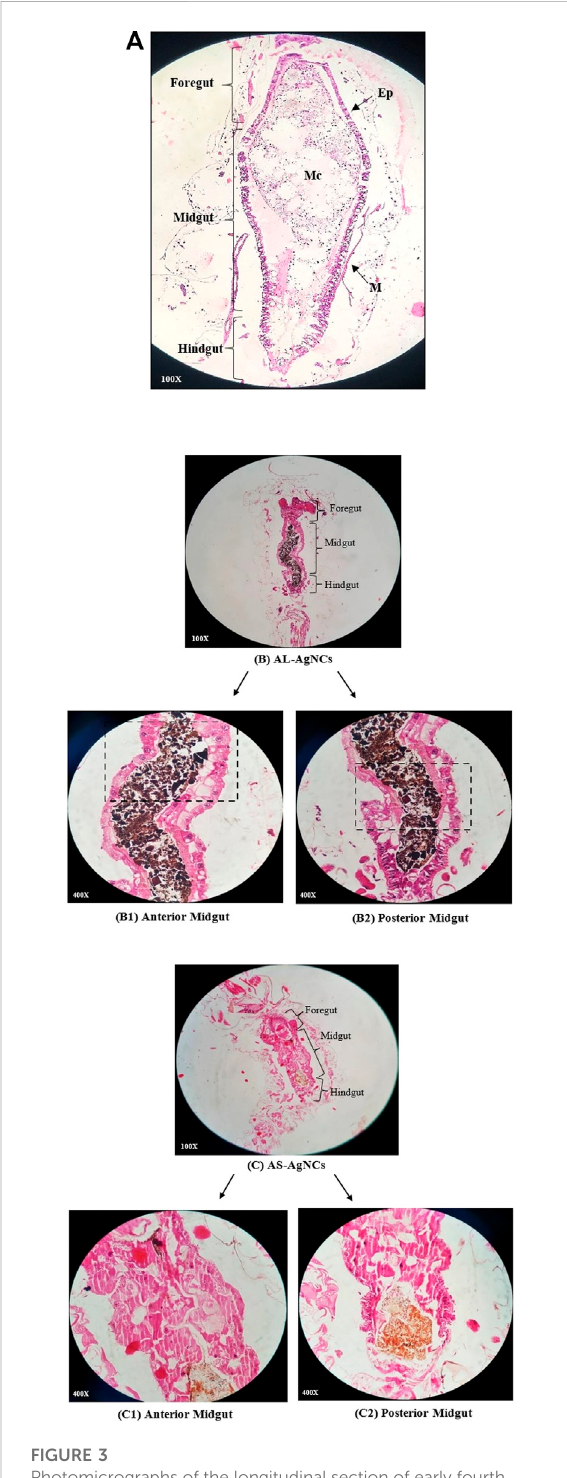
FIGURE 3 Photomicrographs of the longitudinal section of early fourth instar larvae of Aedes aegypti exposed for 24 h to the LC 50 dosage of silver nanocomposites: (A) control, (B) Exposed to Achyranthes aspera leaf extract-mediated silver nanocomposites (AL- AgNCs), and (C) Exposed to Achyranthes aspera stem extract- mediated silver nanocomposites